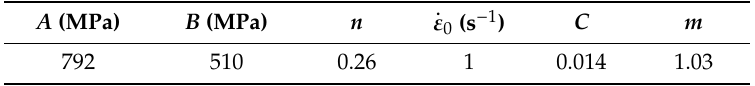
Figure 2. The initial geometry for the nanocomposite helmet at different impact locations.